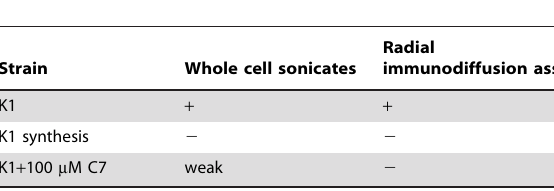
Table 3. Summary of agglutination assays.